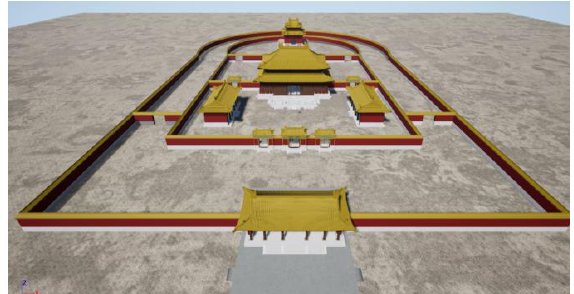
Figure 4. The complete restorative research of Zhaoxi-ling